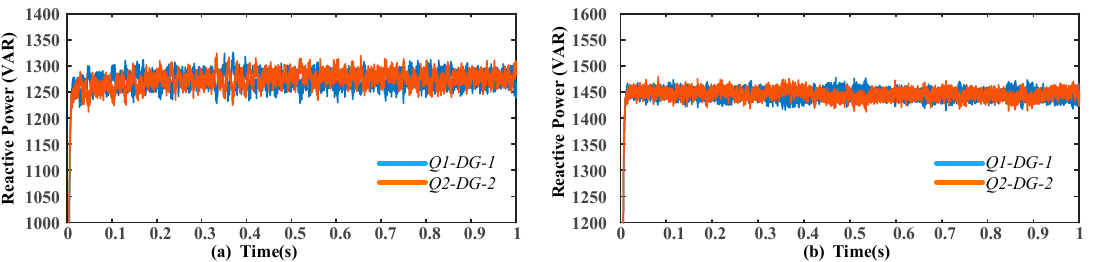
Figure 13. ( a ) Active power for the conventional control strategy; ( b ) active power for proposed control strategy.